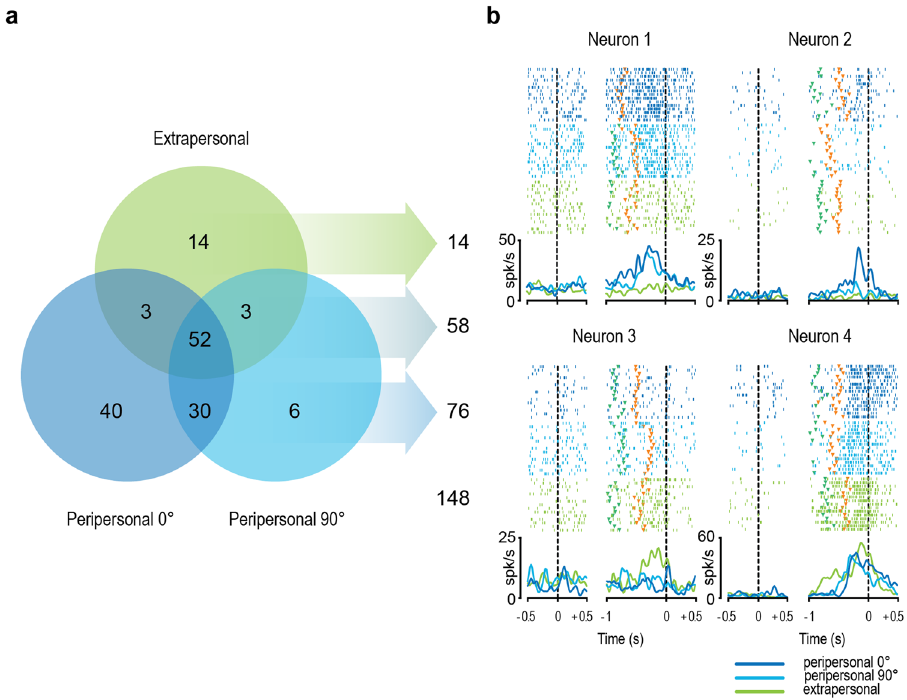
Figure 2. Spatial and/or viewpoint selectivity of the recorded MNs. (a) Venn diagram illustrating the number of MNs significantly activated during single or multiple conditions. (b) Examples of MNs with different spatial and viewpoint selectivity. For each neuron, rasters and spike-density function are aligned (dashed lines) on object presentation (left part) and, after the gap, on the beginning of object-pulling phase (right part). Markers: green, end of the cue sound (go-signal); orange, detachment of the experimenter’s hand from the starting